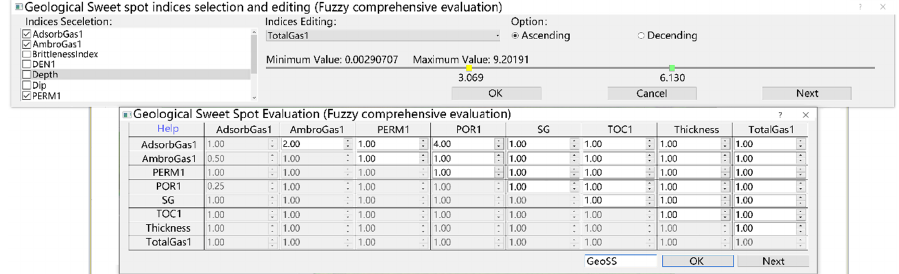
Figure 5. Schematic diagram of parameter selection, sectional interval setting and parameter weight design (in-house development software platform interface).